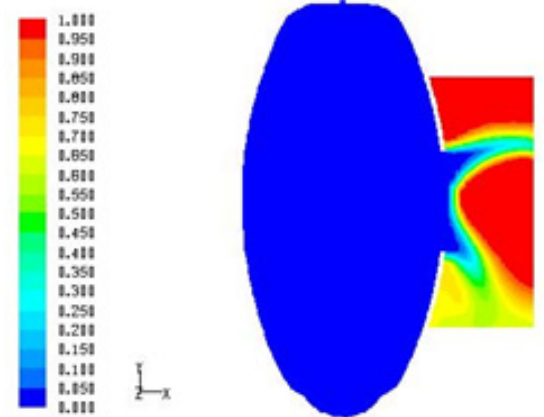
Fig. 3-6. The expressive inner rotating flow causes the spraying of the axial water flow into a conical shape, in the middle filled by back flowed air, deformation due to the gravity. For the chamber of a larger outlet diameter (see below), the air is coming up to the chamber